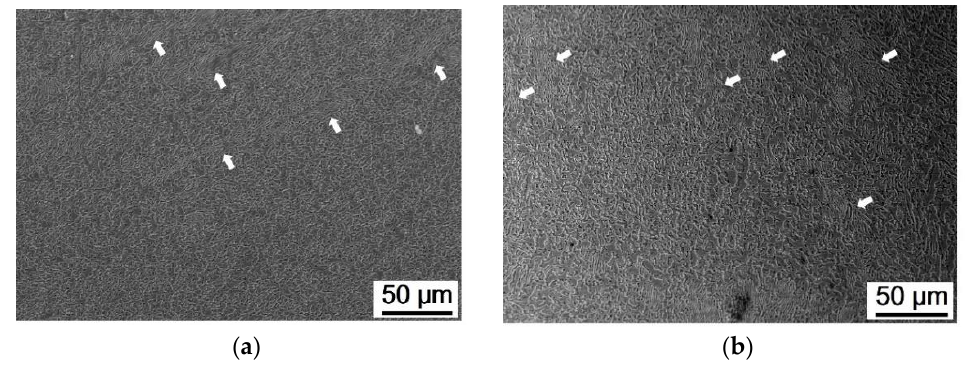
Figure 3. Microstructure of the Bi – Sn samples after t-HPS processing for ( a ) 5 and ( b ) 20 turns and storage at RT for 8 h, with arrows indicating the lamellar bands.